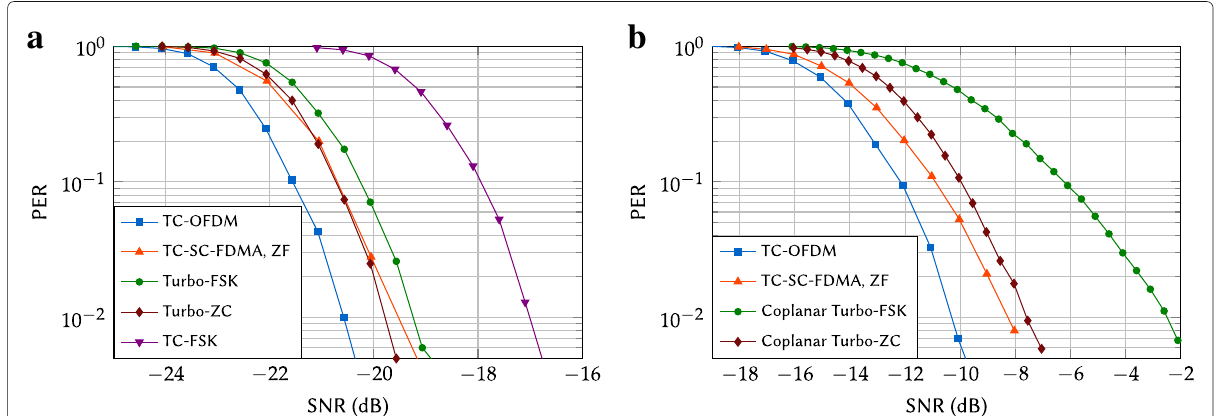
Fig. 6 Performance of the five compared solutions under Rayleigh fading channel with ETU profile. The relative speed is equal to 50 km · h − 1 and the carrier frequency is set to 2.5 GHz, for the first scenario ( a ) and for the second scenario ( b